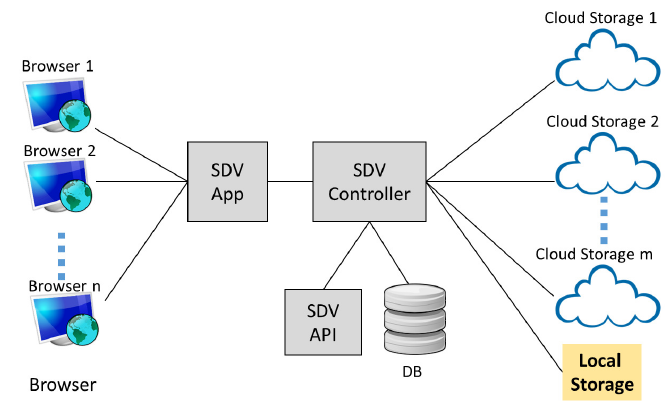
Figure 1. The searchable data vault (SDV) consists of three main components: SDV application, SDV controller, and SDV API. Users access the system through a web browser. The SDV app provides the interface to interact with the users. The SDV controller manages the credentials database, and the core functionalities through interaction with the SDV API, which consists of the searchable symmetric encryption (SSE) scheme, and distributes encrypted documents to storage servers. The servers may include a mix of third-party cloud storage and local in-house storage servers.